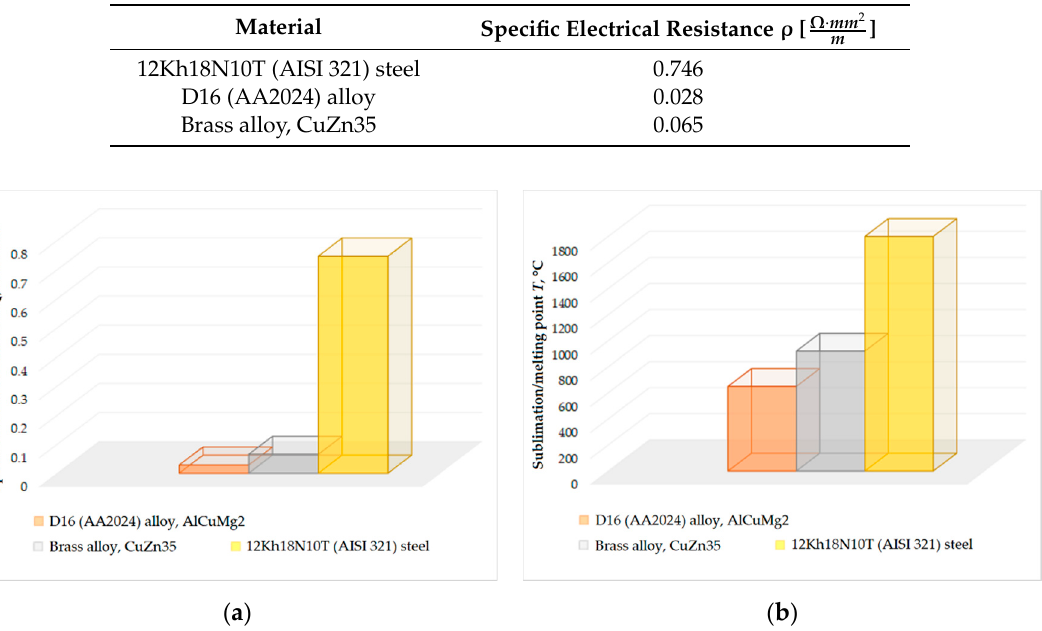
Figure 1. Electrophysical properties of the materials used in experiments: ( a ) specific electrical resistance ρ at +20 °C; ( b ) sublimation/melting point T .